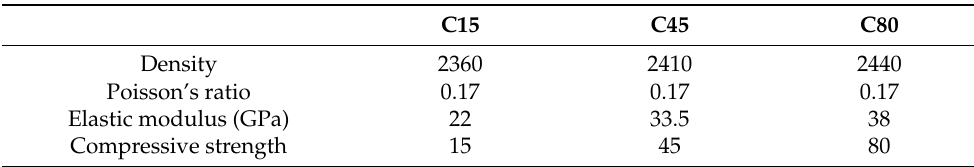
Table 1. The mechanic parameters of chosen concrete.